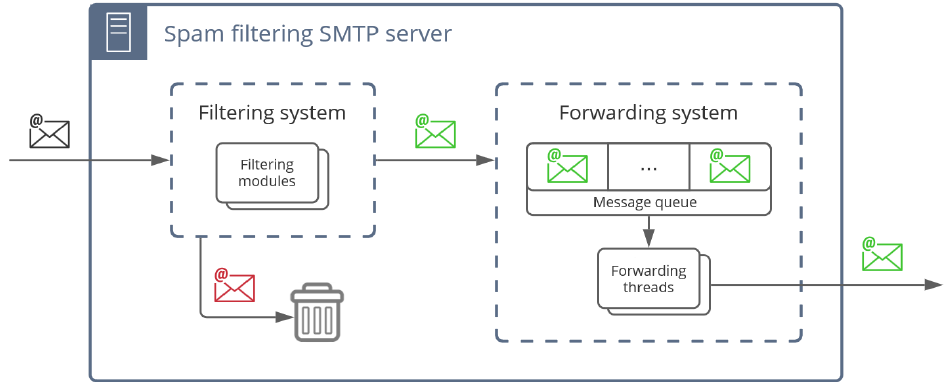
Figure 1. This is a figure: LisB architecture.